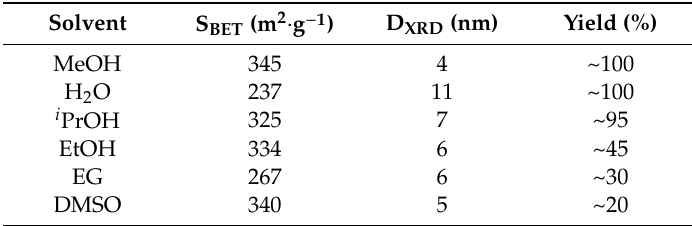
Table 2. Impacts of the solvent on the specific surface areas (S BET ) and particle diameters determined by XRPD (D XRD ) of the nanoparticles of MgF 2 and yield of the synthesis.